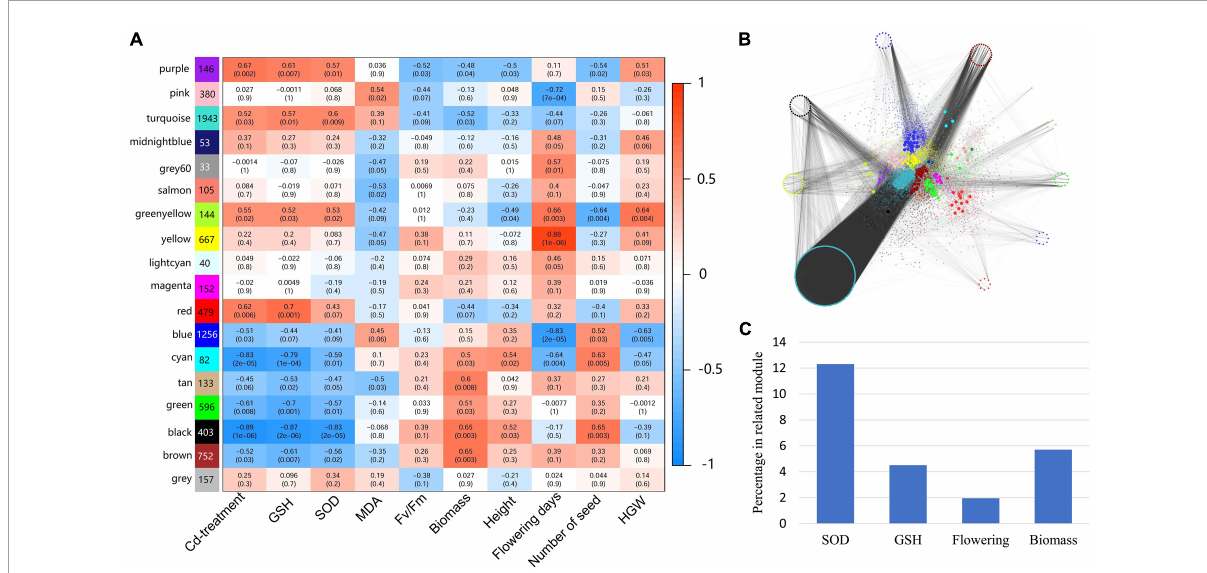
FIGURE6 Correlation of traits and modules, and distribution of TMGs in different modules. (A) Module–trait associations. The module eigengenes and traits are represented in rows and columns, respectively. The corresponding correlation (represented by value and color) and p -value are contained in each cell. Number beside module name indicate count of genes in this module. (B) A global view of TMGs distributed in each module. Modules are represented by different colors, and key hub genes are represented by larger circles. The TMGs are surrounded on the outside. (C) Proportion of TMGs in trait-correlated modules (PCC > 0.6 and p < 0.05). More TMGs were found in SOD-related modules than those of other traits.